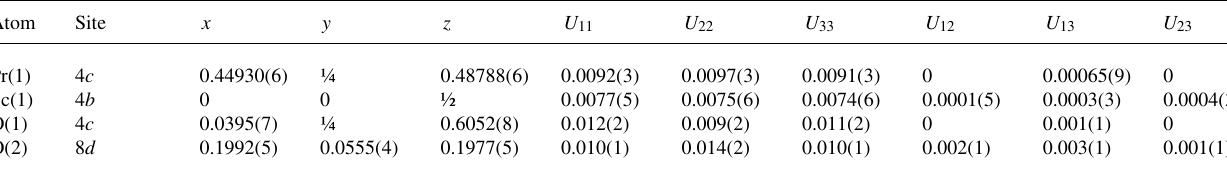
Table 2. Atomic coordinates and displacement parameters (in Å 2 )